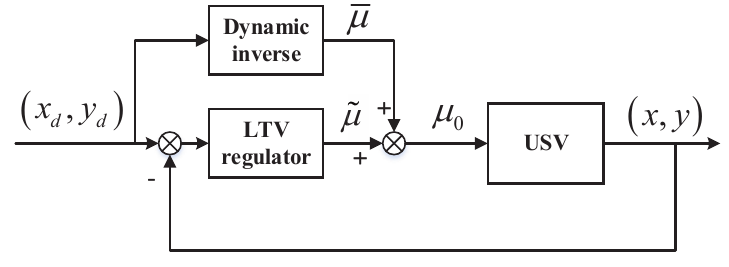
Figure 2. TLC scheme